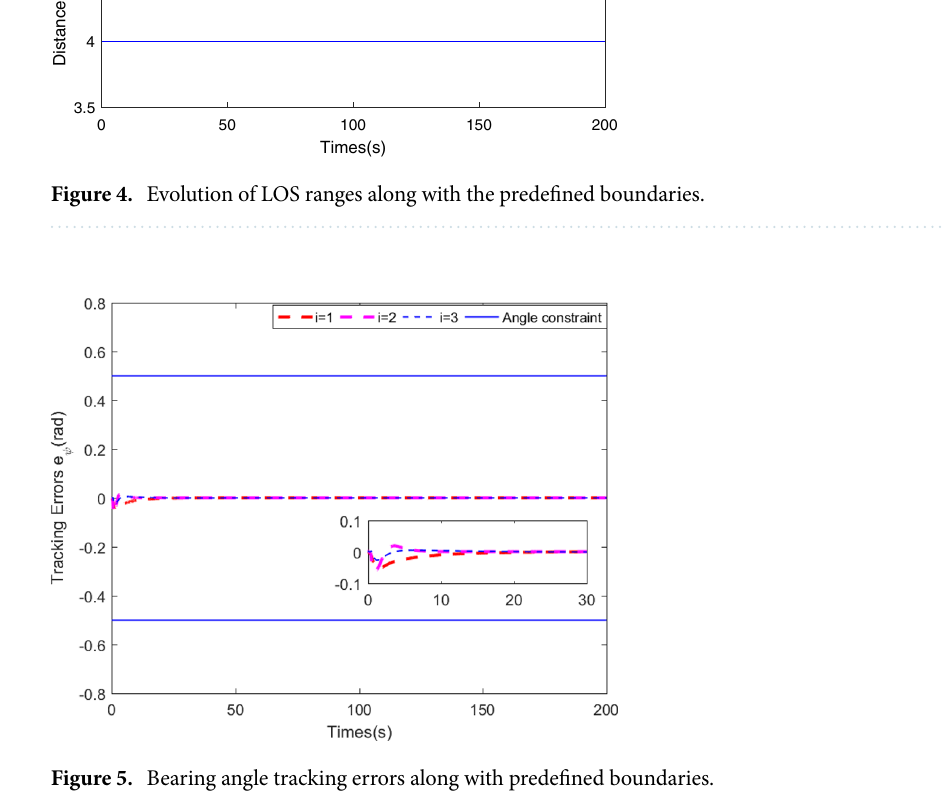
Figure 5. Bearing angle tracking errors along with predefined